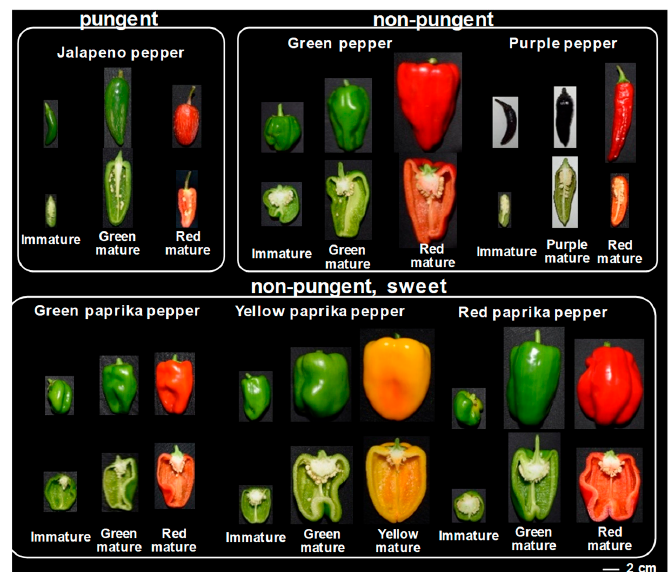
Figure 3. Pepper cultivars used in this study. Fruits from jalapeño pepper cv. “Jalapeño”, red paprika pepper cv. “Flupy Red EX”, purple pepper cv. “Nara Murasaki”, green pepper cv. “Miogi”, yellow